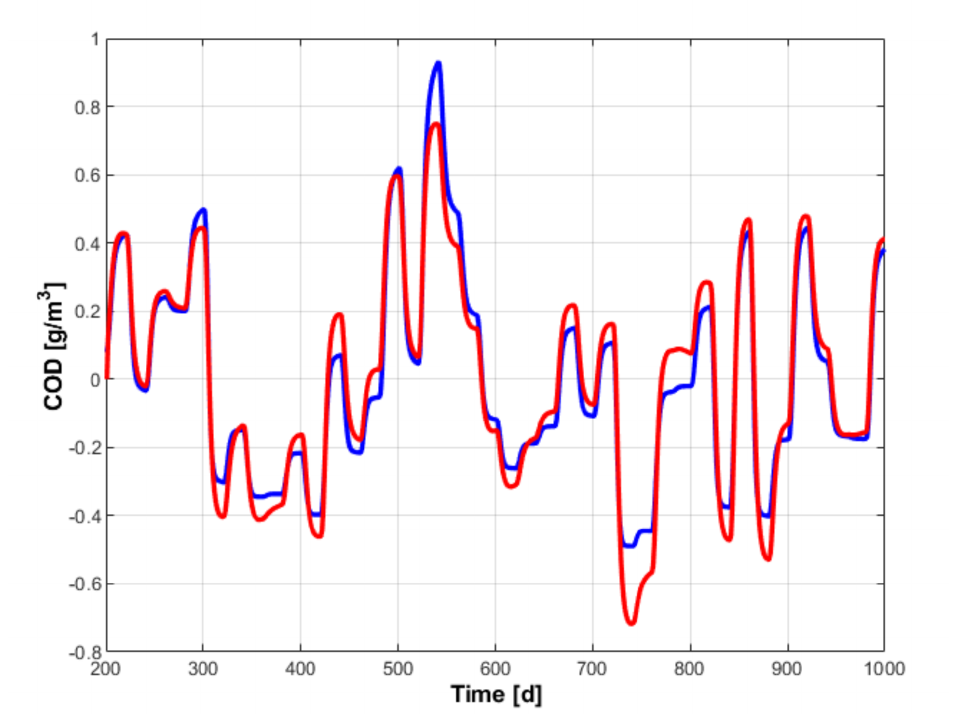
Figure 3. Variations from the average values of the process output sizes (blue) and the identified pattern